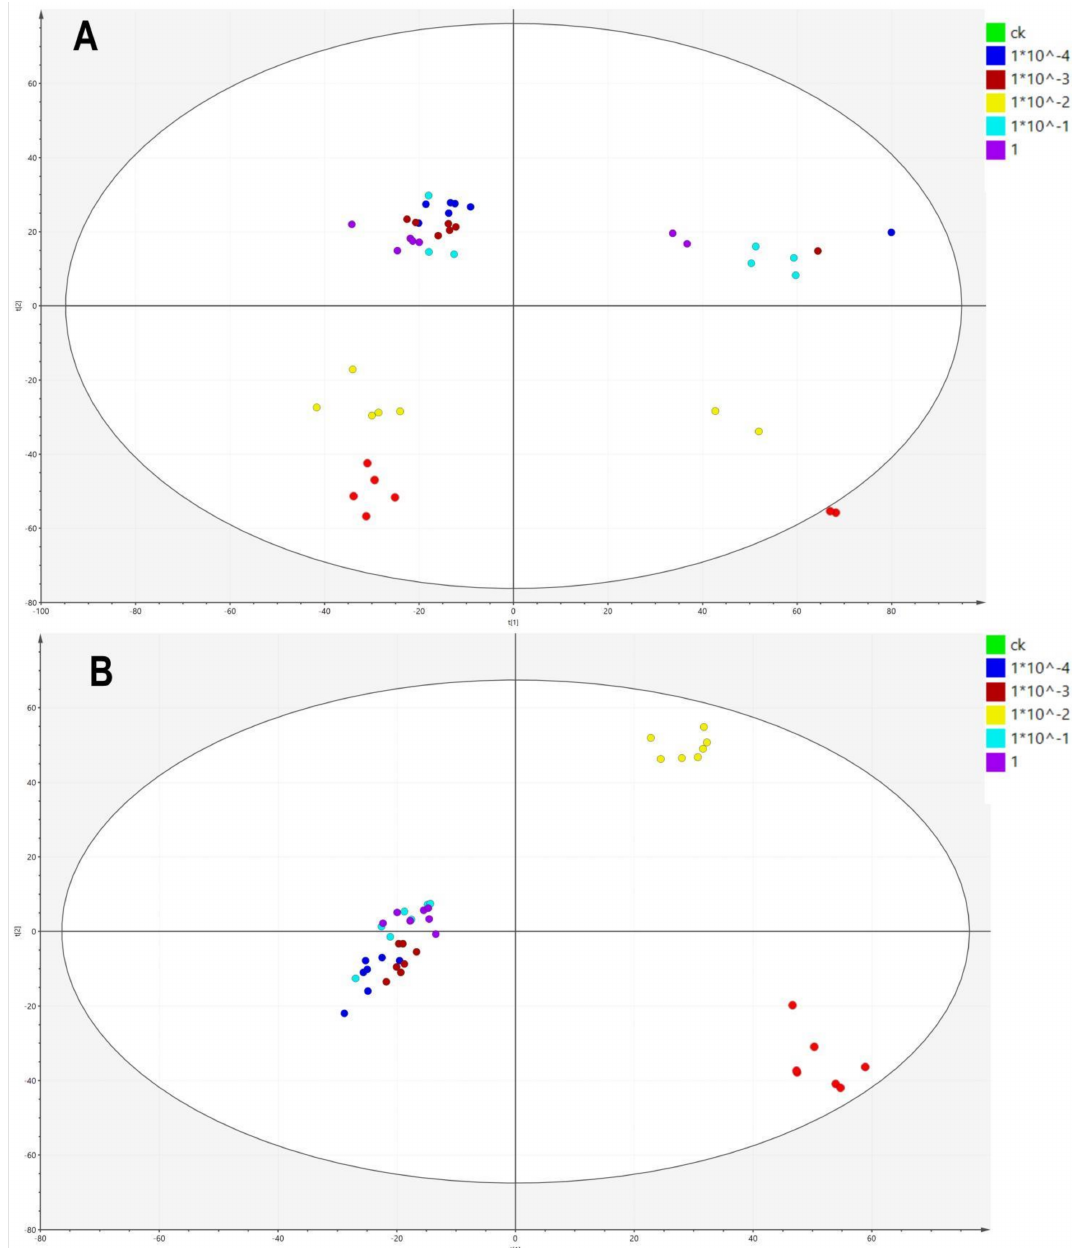
Figure 2. Statistical analysis of six groups (CK, 1 × 10 − 4 , 1 × 10 − 3 , 1 × 10 − 2 , 1 × 10 − 1 mg/L). ( A ) Principal component analysis (PCA) score plot and ( B ) partial least-squares discriminant analysis